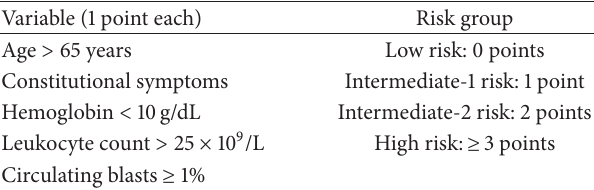
Circulating blasts ≥